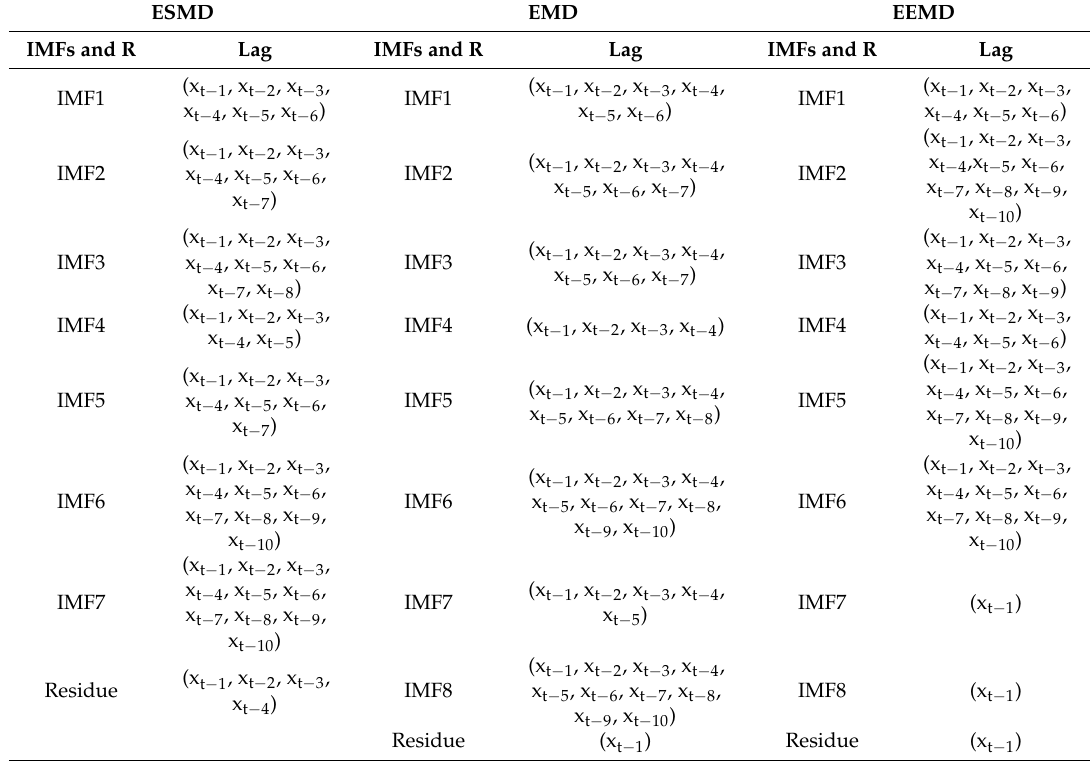
Table 6. The calculation formula.